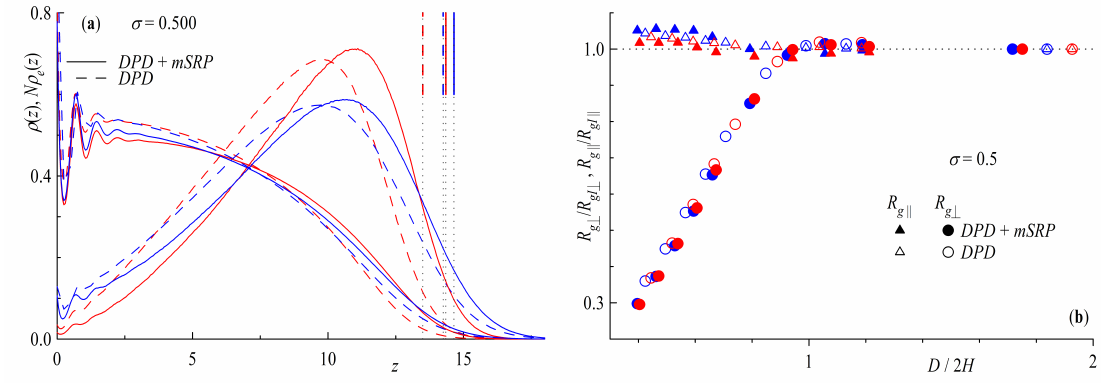
Figure 10. ( a ) Density profiles ρ ( z ) and end (mid) monomer distributions ρ e ( z ) . The short strait lines vertical lines symbolize the 2.5% brush height criteria (see text). ( b ) Parallel R g (cid:107) and perpendicular component R g ⊥ of the radius of gyration scaled with value of infinite separation R gI (cid:107) and R gI ⊥ . Both as a function of brush distance D scaled by two times the brush height at infinite separation H at a surface coverage of σ = 0.5. Red symbols are rings with N rings = 64 and blue for tails N tails = 32. Dashed lines and empty symbols for standard Dissipative Particle Dynamics (DPD) and full lines and symbols for DPD + modified Segmental Repulsion Potential (mSRP) (with bond repulsion